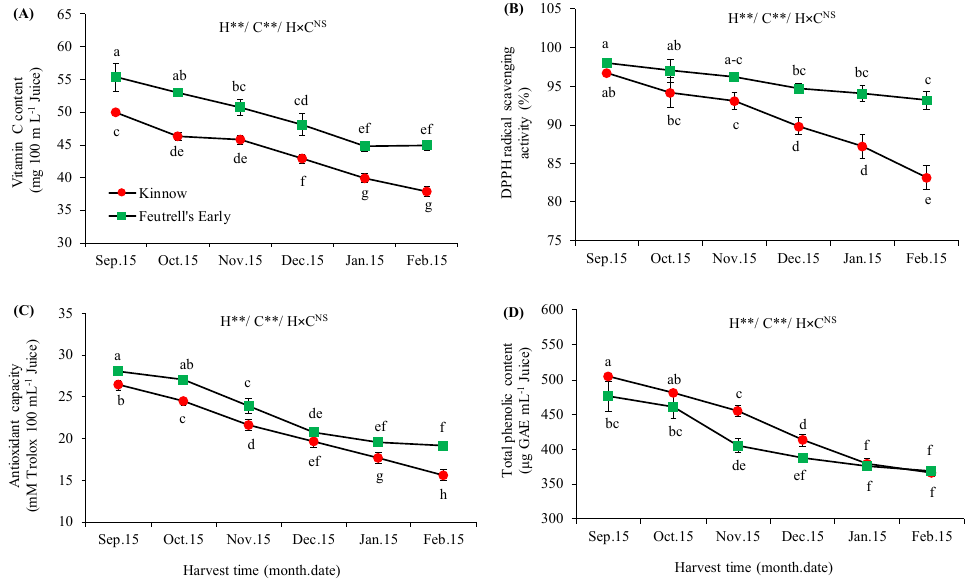
Figure 5. Changes in vitamin C content ( A ), DPPH radical scavenging activity ( B ), antioxidant capacity ( C ), and total phenolic content ( D ) of mandarin fruits (Kinnow and Feutrell’s Early) at different harvest times. Error bars show standard errors of the means ( n = 4). Different lowercase letters in each graph indicate significant differences at p < 0.05 between tested samples at different times by the least significant difference test. H and C stand for harvest time and cultivar, respectively. H × C presents the effect of the interaction of harvest time and cultivar. NS, non-significant; significant at ** p <